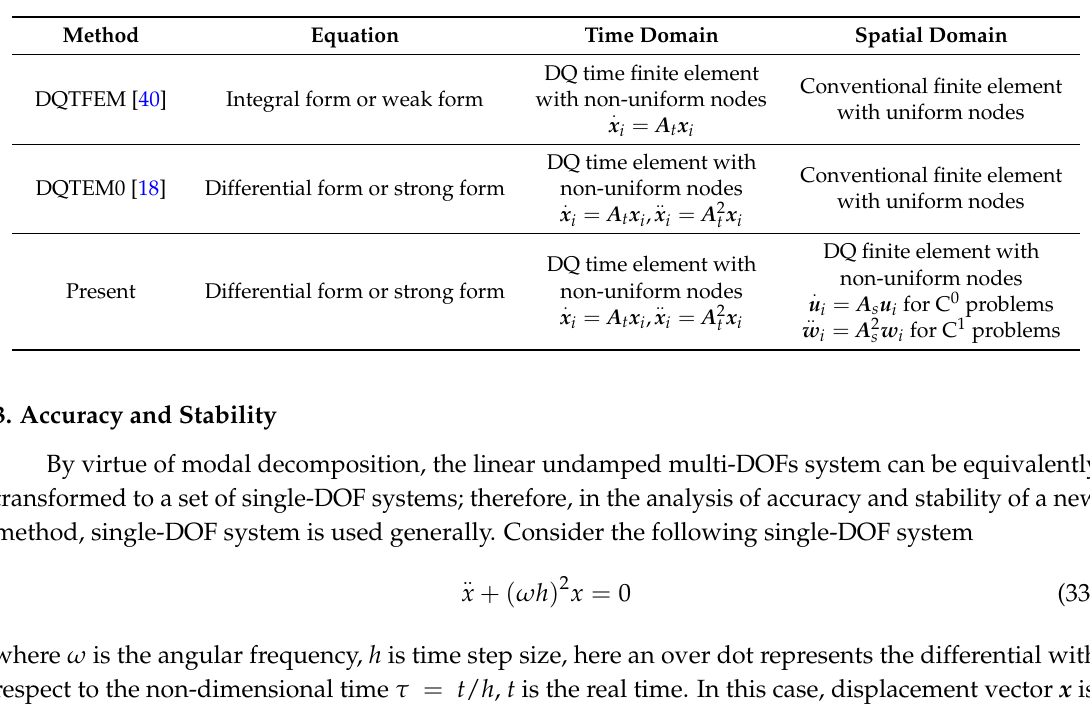
Table 1. Comparison among DQTFEM (Differential Quadrature Time Finite Element Method), DQTEM0 and the improved